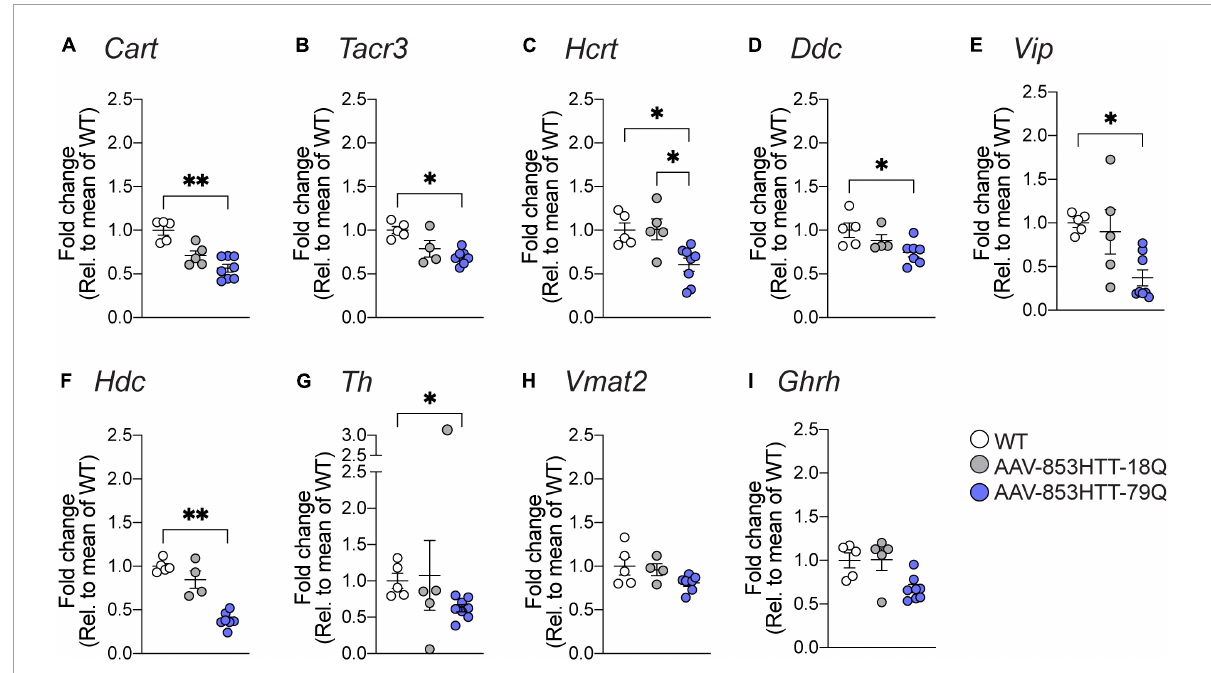
FIGURE5 Quantitative real-time polymerase chain reaction (qRT-PCR) validation of differentially expressed genes in wtHTT 18Q and mHTT 79Q groups. Gene expression analysis of candidate genes was performed with hypothalamic RNA samples from mice with targeted mutant HTT (79Q) overexpression and wild-type HTT (18Q) overexpression (4 weeks post-injection). Data are expressed as mRNA expression relative to the mean of uninjected WT controls. (A) Cocaine and amphetamine-regulated transcript ( Cart , p = 0.0031), (B) Tachykinin receptor 3 ( Tacr3, p = 0.0148), (C) Hypocretin neuropeptide precursor ( Hcrt, WT vs. 79Q: p = 0.0326, 18Q vs. 79Q: p = 0.0393), (D) Dopa decarboxylase ( Ddc, p = 0.0136), (E) Vasoactive intestinal peptide ( Vip, p = 0.0149), (F) Histidine decarboxylase ( Hdc, p = 0.0032), (G) Tyrosine hydroxylase ( Th, p = 0.0257), (H) Vesicular monoamine transporter 2 (Vmat2; encoded by Slc18a2 ), and (I) Growth hormone-releasing hormone ( Ghrh ). The data are represented as scatter dot plots, and bars represent mean ± SEM, and the Kruskal-Wallis test, followed by Dunn’s multiple comparisons, was used to compare the groups. *Denotes p -value is 0.01 to 0.05 and **denotes p -value is 0.001 to